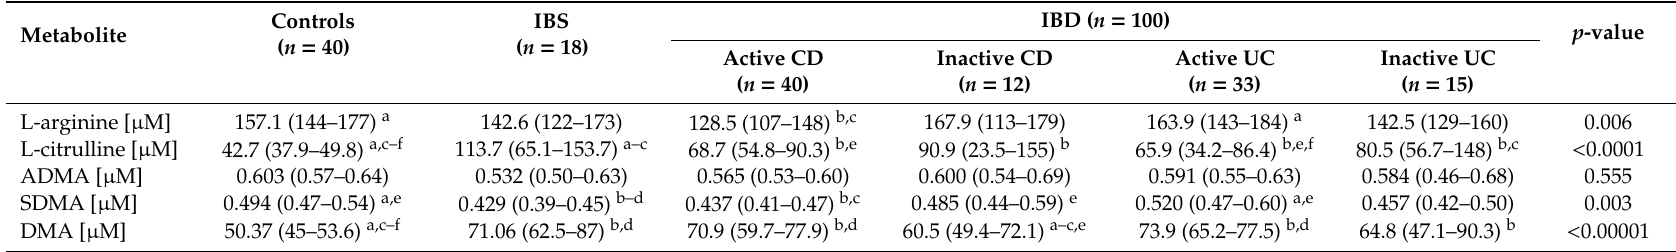
Table 2. Systemic concentrations of L-arginine / NO pathway metabolites in reference to IBD phenotype and clinical